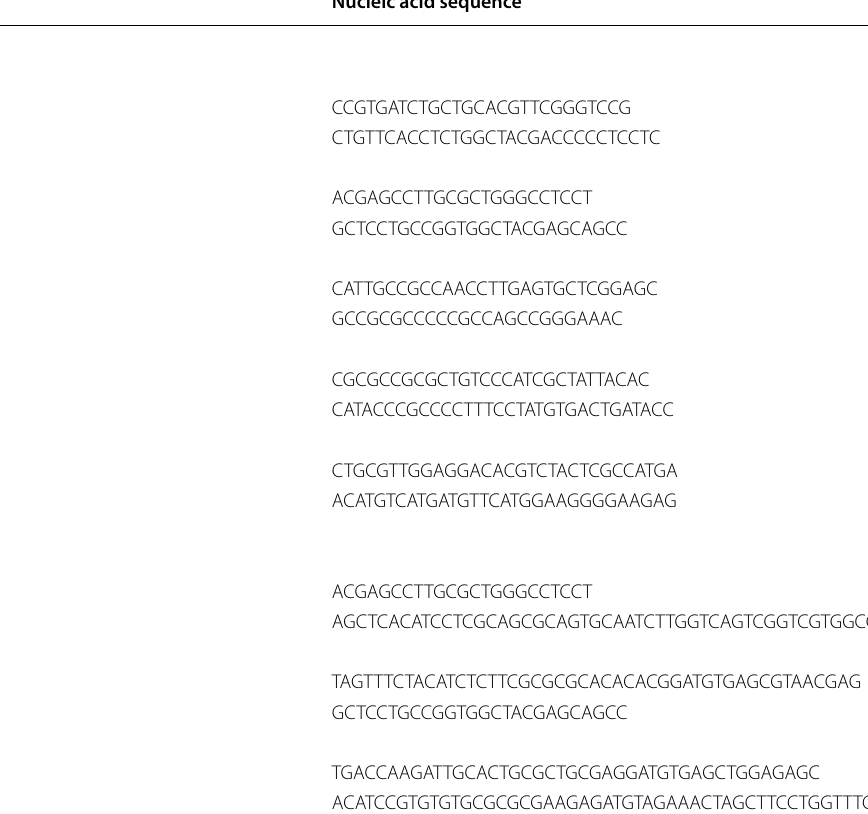
Table 1 Primers used in this study Primers Nucleic acid